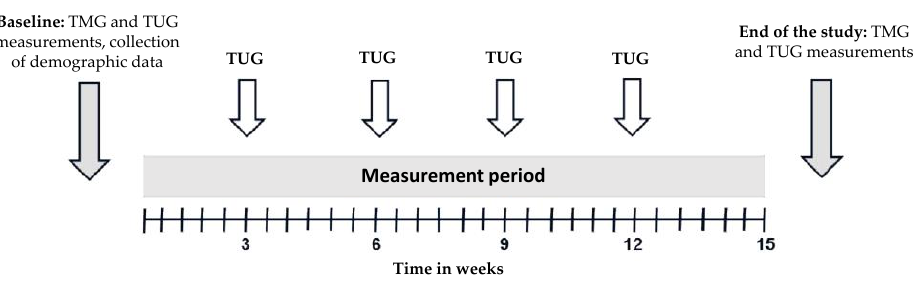
Figure 5. Timeline of the study. Participants could attend six Timed Up-and-Go ( TUG ) test measure- ments and two tensiomyography ( TMG ) measurements within 15